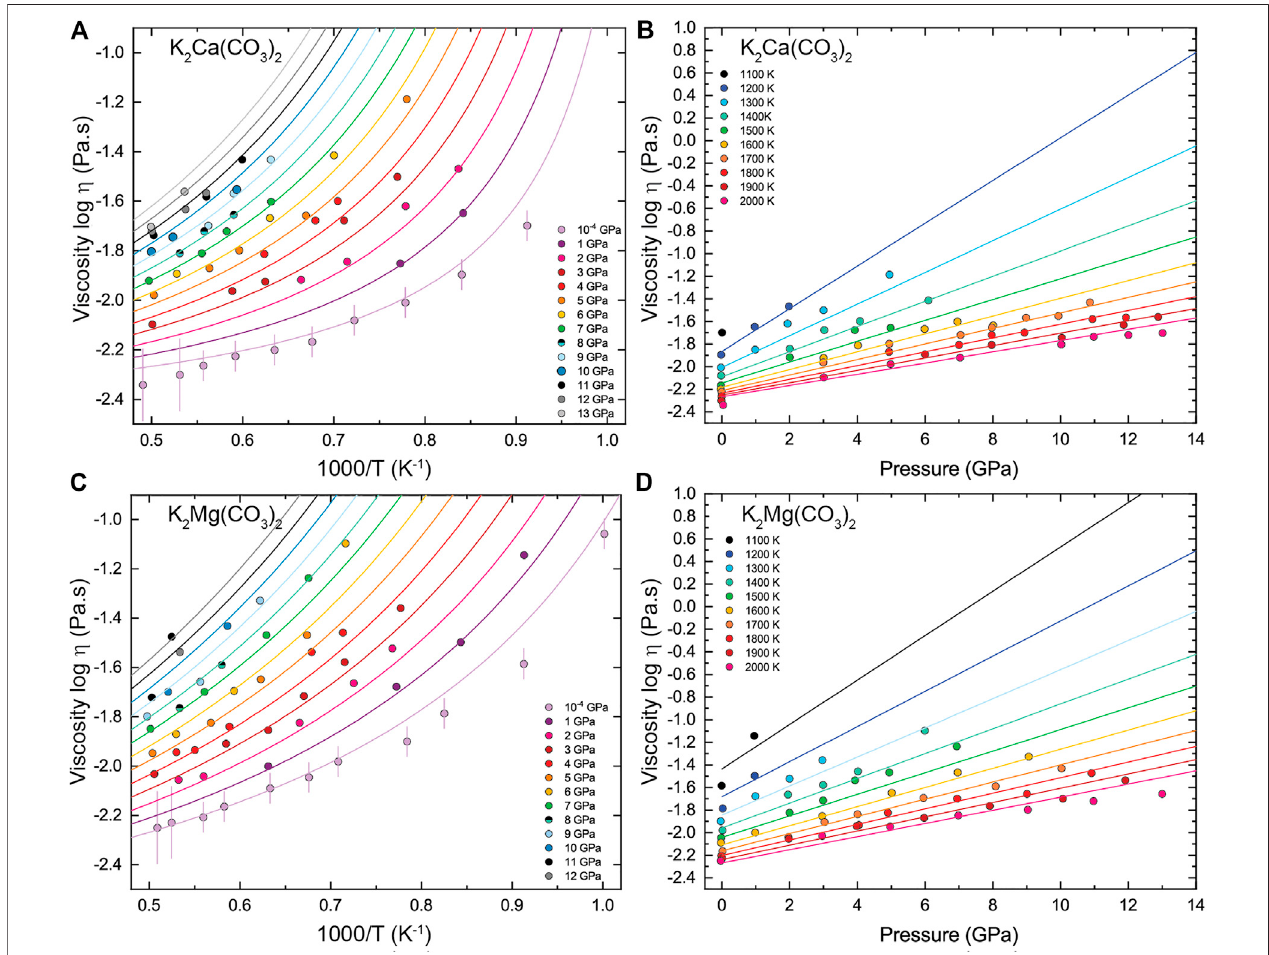
FIGURE 3 | Temperature and pressure dependence of the viscosity of (A) – (C) K 2 Ca(CO 3 ) 2 (KC) and (B) – (D) K 2 Mg(CO 3 ) 2 (KM) melts. Symbols are MD calculated viscosities in this study. Solid lines represent fi ts to temperature- and pressure-dependence by the VFT model [ Eq. 6 ]. Error bars in a) and b) correspond to ± 15% up to 1,800 K ( < 0.55 K − 1 ) and ± 40% at the higest temperatures. For the sake of clarity, error bars are only reported for the room pressure data but apply to all other isobars.